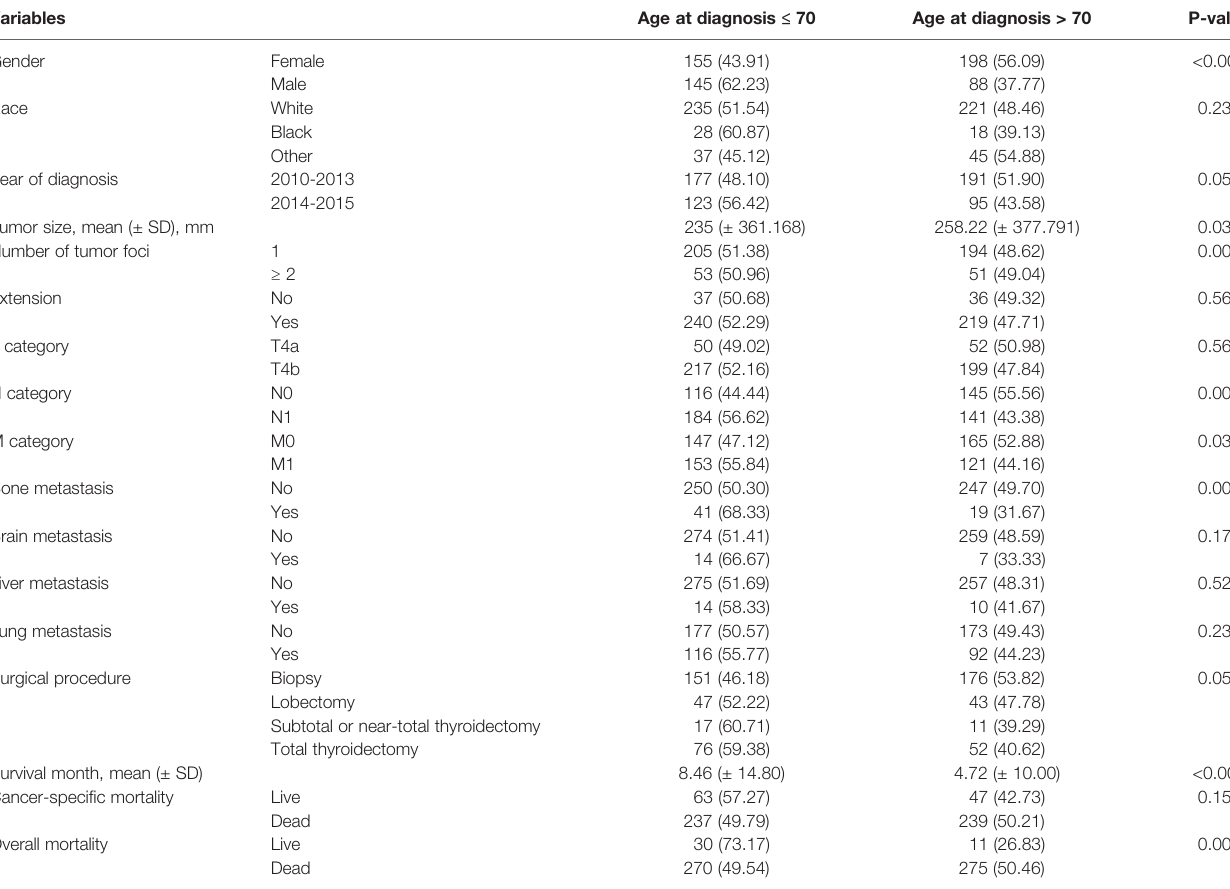
TABLE 5 | Comparisons of clinicopathological characteristics between patients who were ≤ and > 70 years-old at the time of diagnosis of anaplastic thyroid cancer.